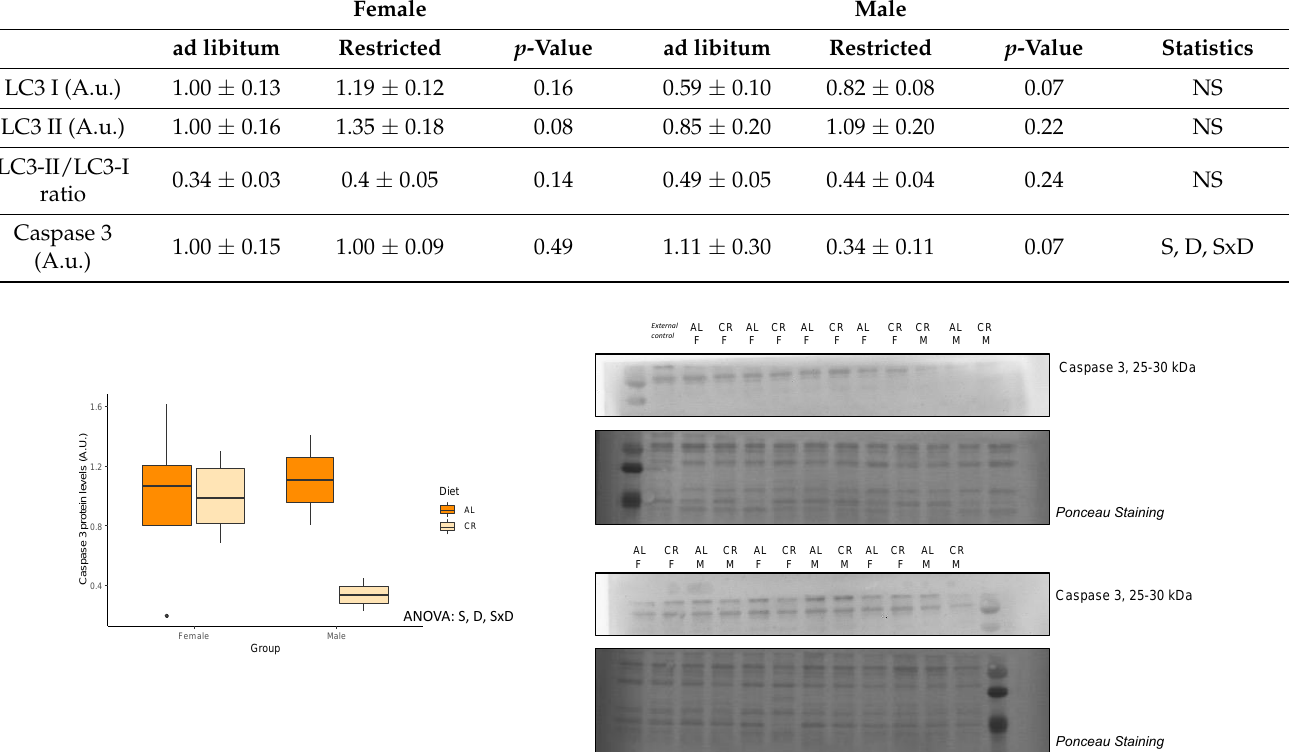
Table 6. Protein levels of LC3-I and LC3-II, and caspase 3 analyzed by Western Blot. Two-way ANOVA was performed to assess for significance. Abbreviations: S, sex differences; D, diet differences; SxD, interactive effect between sex and diet; NS, non-significant.